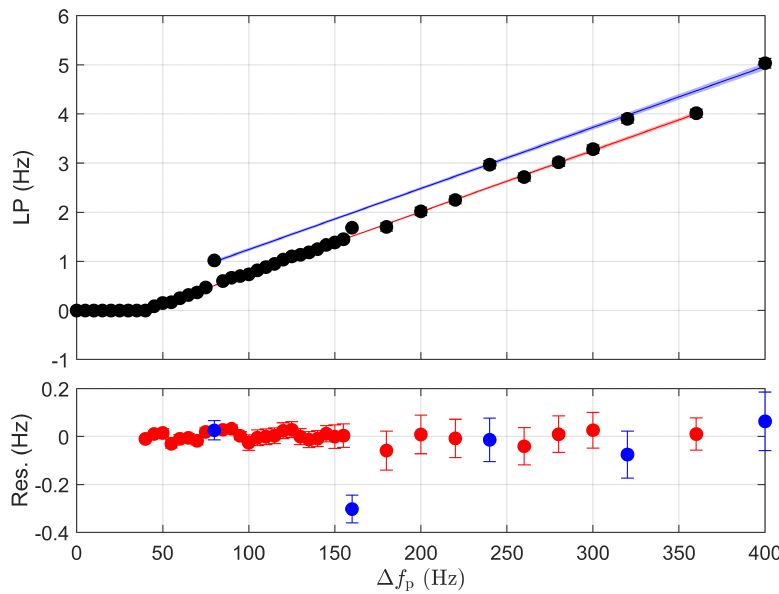
Figure 10. ( Top plot ): loss packet rate LP by the DUT as a function of difference from nominal publishing rate ∆ f p of the input SV. The circles represent the measured data, whereas the solid lines with shaded areas are the fit with corresponding uncertainties. ( Bottom plot ): residuals between data and the corresponding fit mode highlighted with corresponding fit